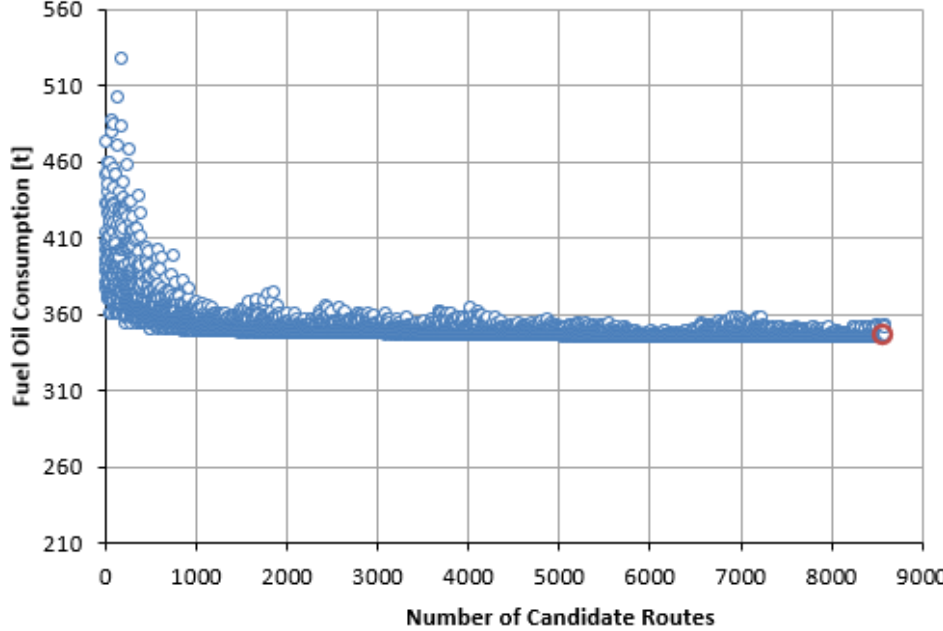
Figure 5. Algorithm’s evolution with constant speed and clean hull and propeller.